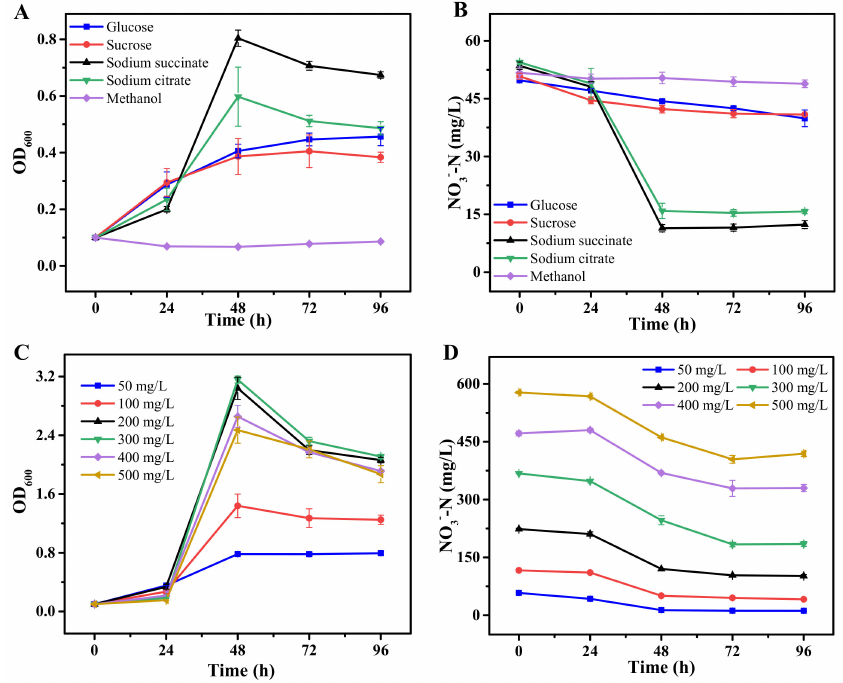
Figure 1. Effect of different carbon sources ( A , B ) and nitrate concentrations ( C , D ) on the growth and nitrogen removal performance of